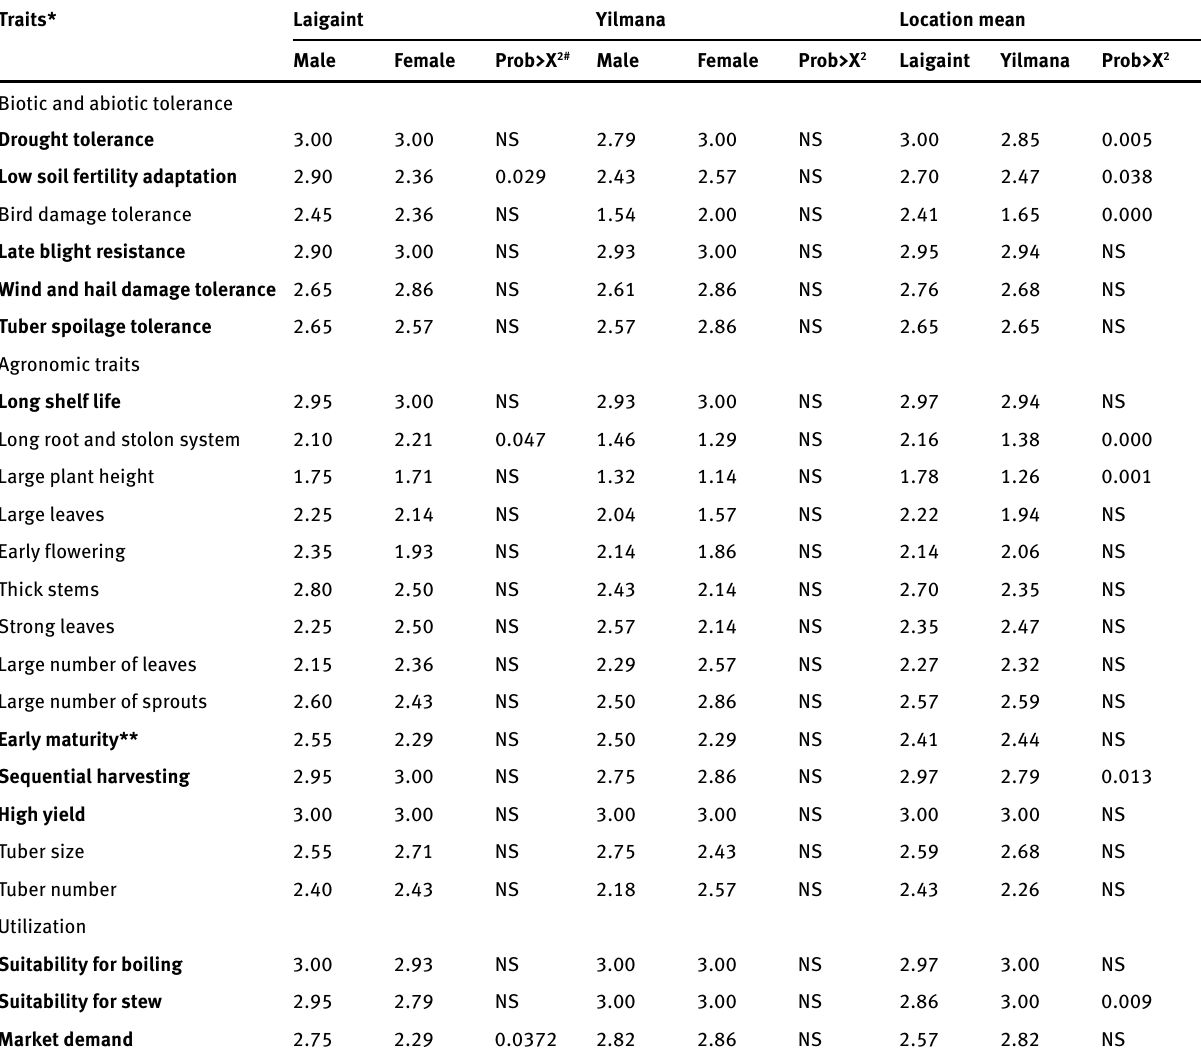
Table 2: Average ratings of potato variety trait importance by district and gender Traits* Laigaint Yilmana